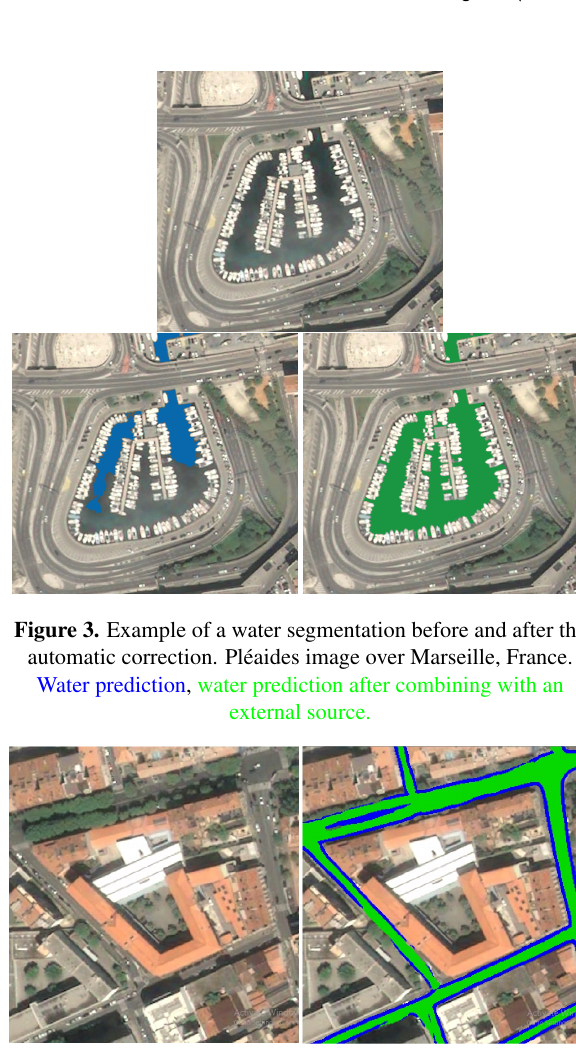
Figure 4. Left: input orthoimage, right: our road prediction with road, contour, other (transparent).